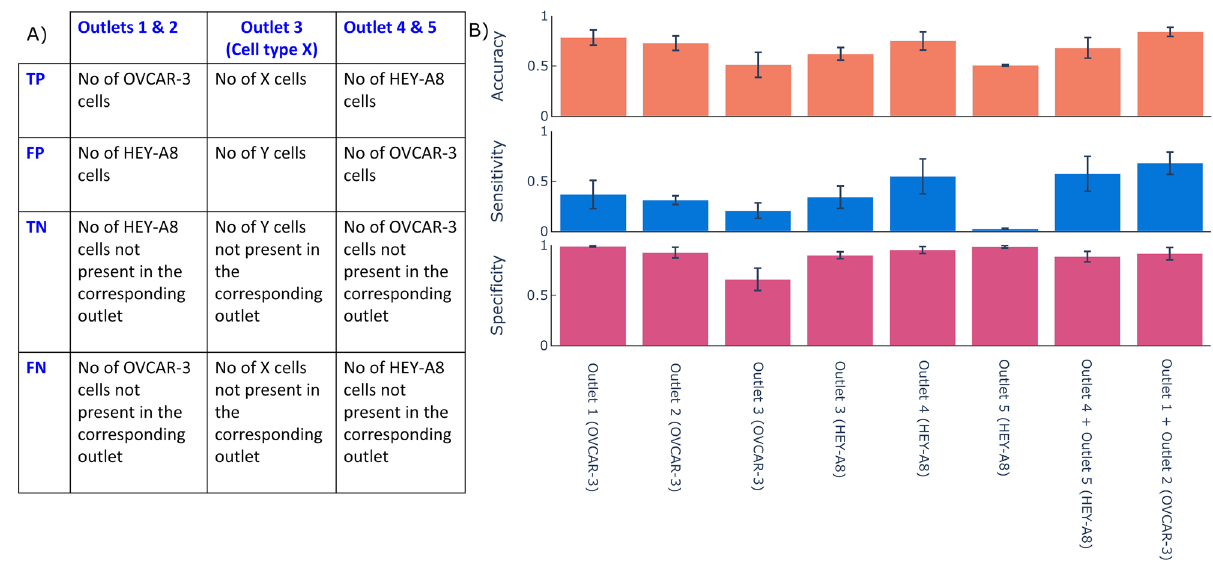
Figure 5. Sensitivity, specificity and accuracy analysis. ( A ) Definitions of true positive, true negative, false positive and false negative used for our sensitivity analysis. ( B ) The sensitivity, specificity and accuracy of sorting cells using our platform for each outlet, as well as for combinations of some neighboring outlets. The cell line in parentheses in the x axis label indicates which cells were considered true positives in the